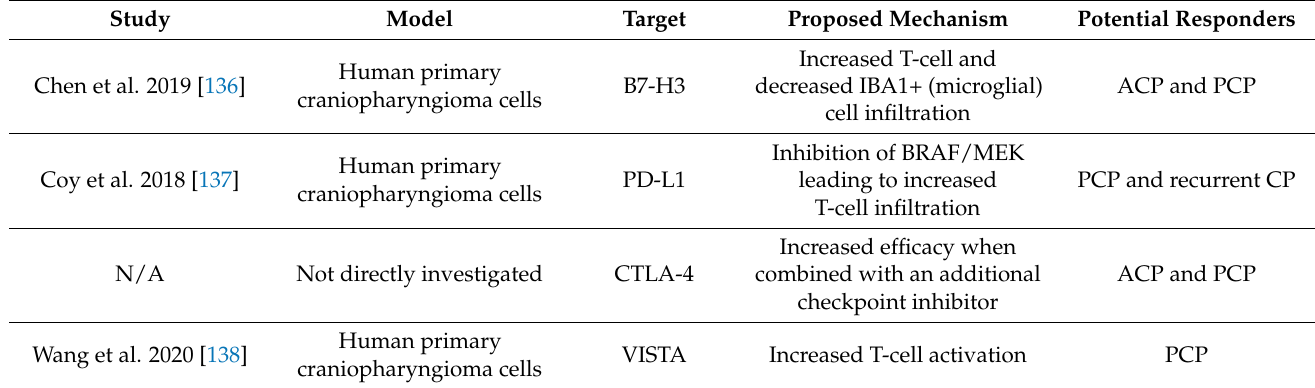
Table 4. Clinical trials that have included immunological targets for the treatment of